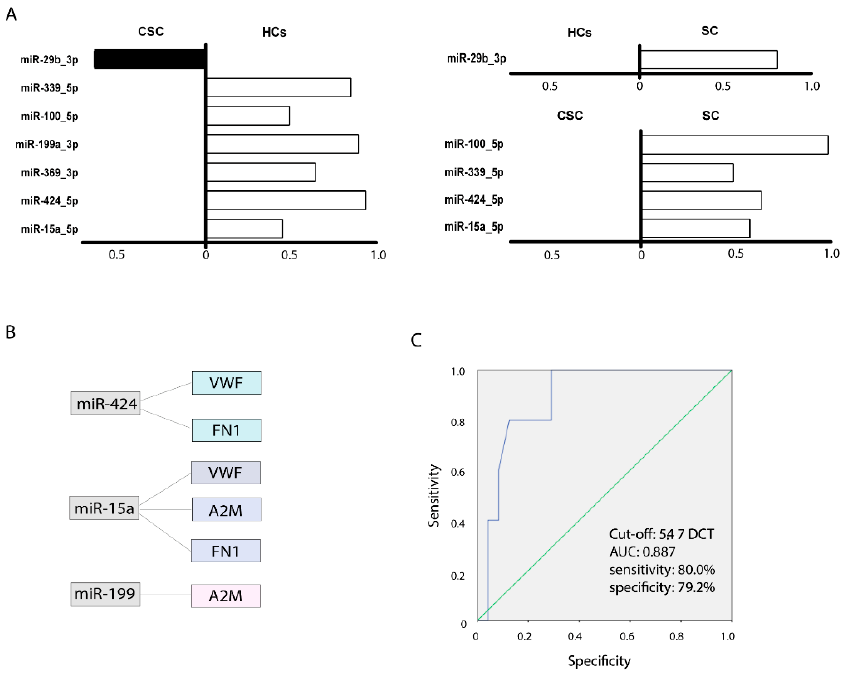
Figure 4. Significant miRNAs in serum-derived extracellular vesicles of healthy controls and patients with ischaemic stroke: ( A ) miRNA levels in patients with CSC stroke compared with HCs (left), HCs compared with patients with SC stroke (above right), and patients with CSC stroke compared with patients with SC (below right); ( B ) bioinformatics analysis of microRNAs and their predicted targets; ( C ) ROC curve representing the cut-off point corresponding to the maximum sensitivity and specificity values in order to identify the miRNA-100-5p levels to predict a >50% improvement from baseline NIHSS score at 3 months. Abbreviations: A2M, alpha-2-macroglobulin; AUC, area under the curve; CSC, cortical-subcortical stroke; FN1, fibronectin 1; HCs, healthy controls; SC, subcortical stroke; VWF, Von Willebrand